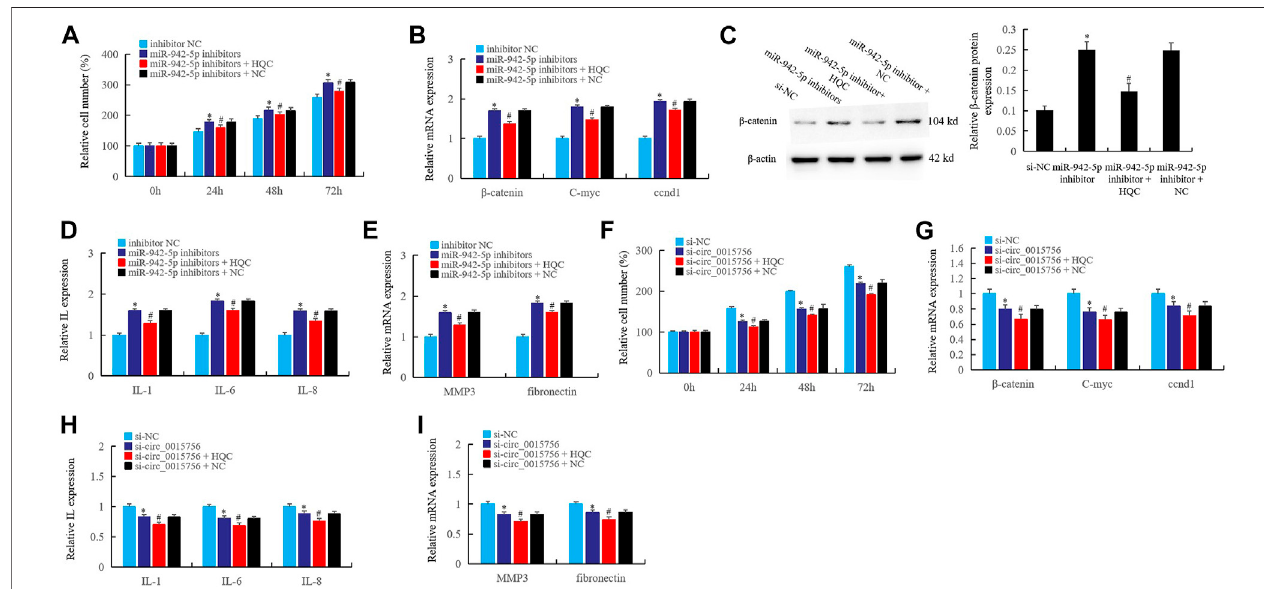
FIGURE 7 | The interference effects of HQC on the circ_0015756/miR-942-5p/ CUL4B / β -catenin axis in RA FLS. The interference effects of HQC on the circ_0015756/miR-942-5p/ CUL4B / β -catenin axis was detected. (A) : cell counting; the interference of HQC on the miR-942-5p silencing was detected by real-time qPCR (B) and westernblotting (C) ;HQC interfered themiR-942-5p toaffect theexpression ofIL-1,IL-6, IL-8 (D) and the MMP3 and fi bronectin (E) inRAFLS; (F) :HQC affected the cell proliferation activity ofRA FLS by interfering the circ_0015756; HQCinterfered the circ_0015756 and the in fl uence on Wnt signal wasdetected by real-timeqPCR (G) ;HQCinterferedthecirc_0015756toaffecttheexpressionofIL-1,IL-6,IL-8 (H) andthe MMP3 and fi bronectin (I) inRAFLS.For (A – E) ,*miR-942-5p inhibitorgroupwascomparedwithinhibitorNCgroup;#miR-942-5pinhibitor+HQCgroupwascomparedwithmiR-942-5pinhibitorgroup.For (F – I) ,*Si-circ_0015756 group was compared with si-NC group; #si-circ_0015756 + HQC group was compared with si-circ_0015756 group.